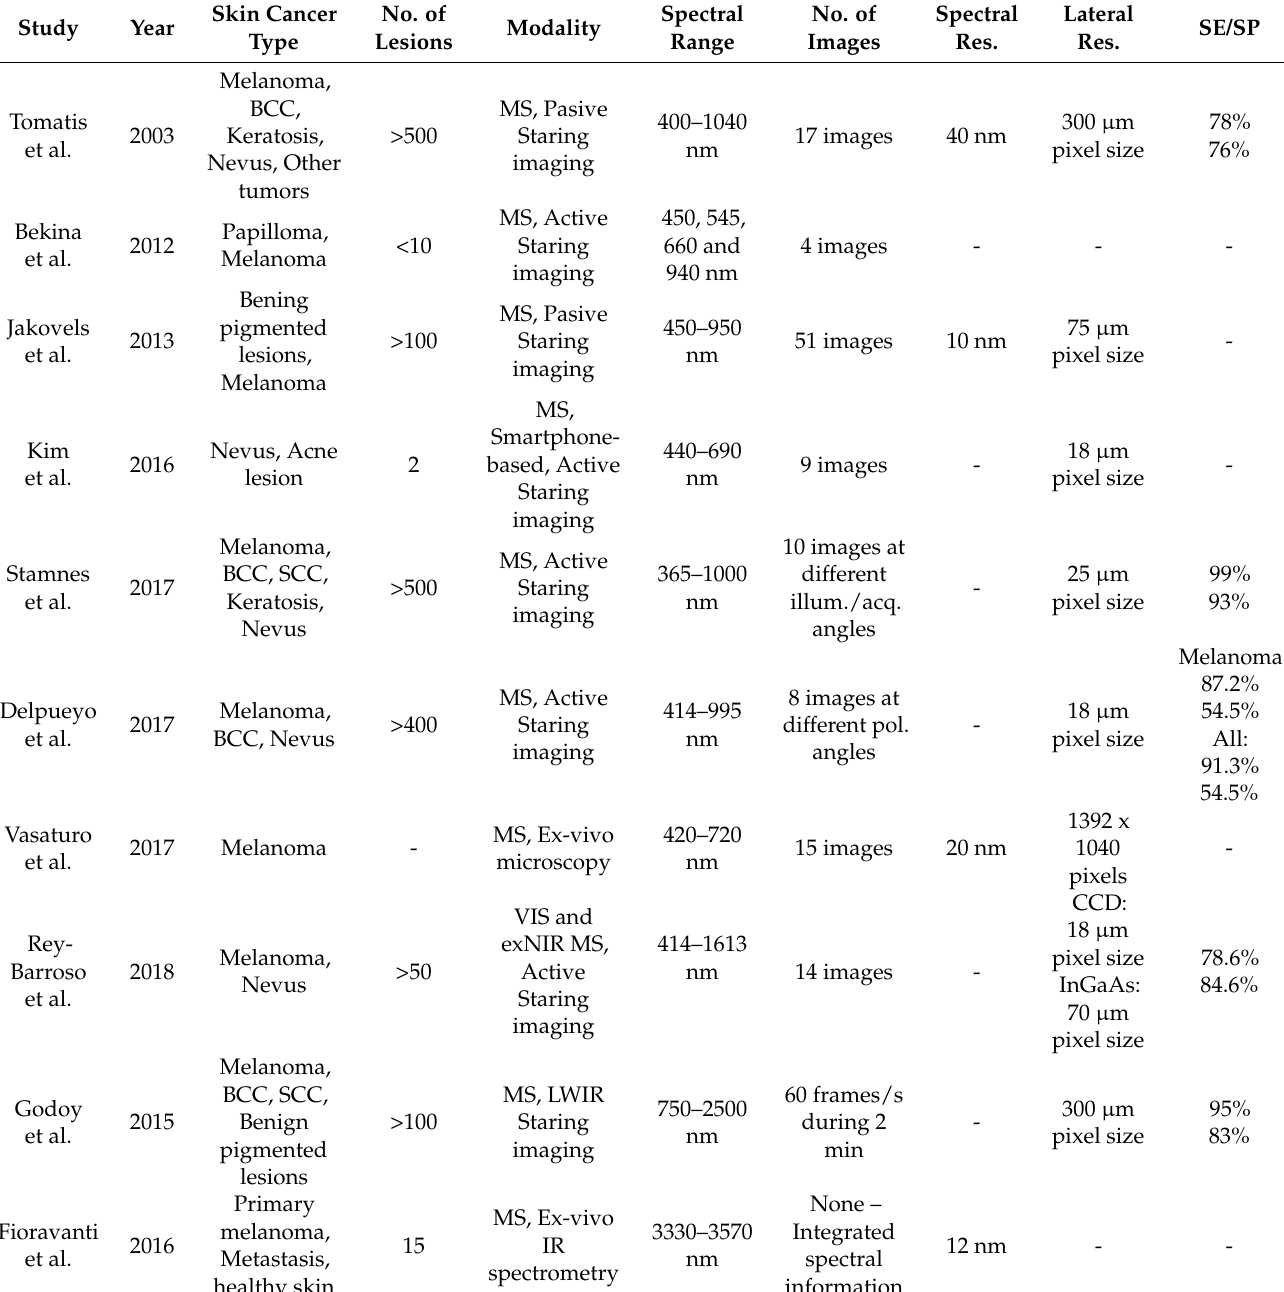
Table 2. Contributions of MS imaging to skin cancer